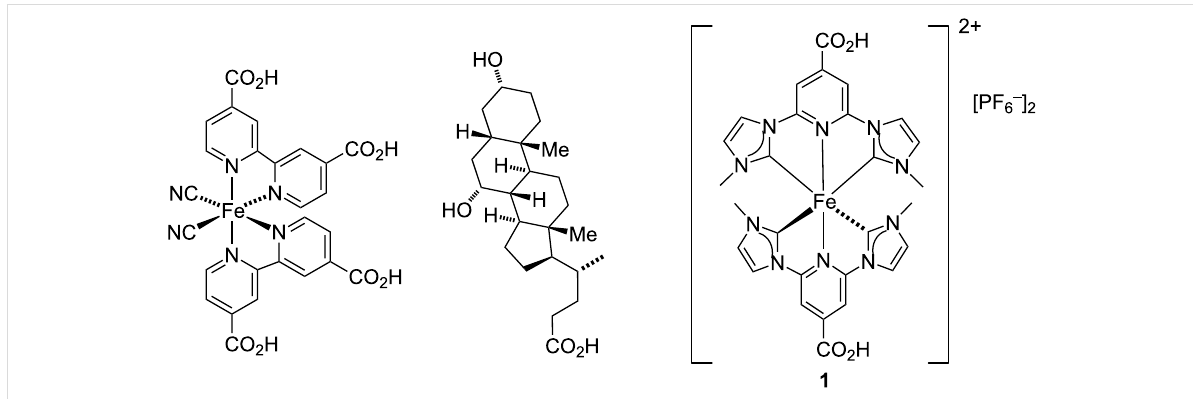
Scheme 2: Structures of cis -[Fe{bpy-4,4'-(CO 2 H) 2 } 2 (CN) 2 ], the co-adsorbant cheno, and the NHC iron(II) dye 1 used in this investigation.